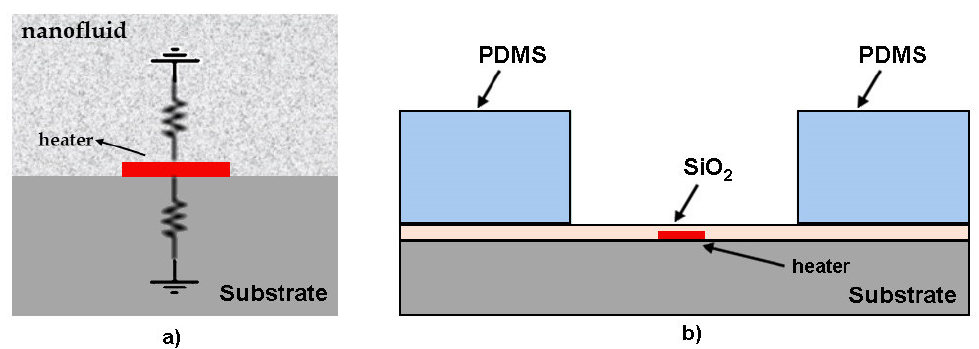
Figure 12. ( a ) Schematic and equivalent thermal circuit of the heater and two semi-infinite mediums of the nanofluid and the substrate; Microfabricated heater device for measuring thermal conductivity of nanofluid and ( b ) cross-section of the heater on 2 mm thick quartz substrate (not to scale) (adapted from Oh et al. [93]).